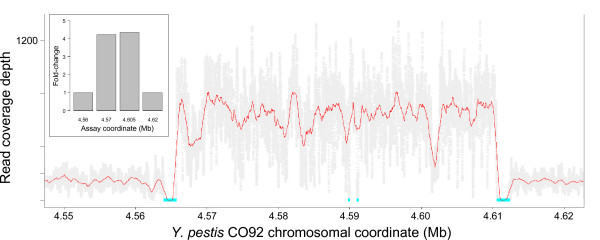
Validation of amplification in Y. pestis strain La Paz. The amplified region is depicted as in Figure 1. Positions of IS1661 elements on the CO92 chromosome are indicated by cyan bars flanking the amplification. Inset: TaqMan® assays were designed, two internal to the amplified region and one to each side, with the approximate coordinates indicated on the X-axis. These assays were run in triplicate on genomic DNA from each of the two strains, and relative fold-change of La Paz versus CO92 was calculated and normalized to the assay at coordinate 4,560,000.